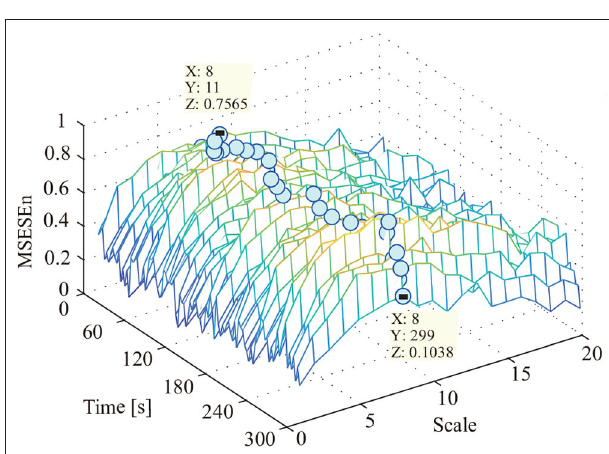
FIGURE 7 | MSESEn of reconstructed signal using OCEEMD with different